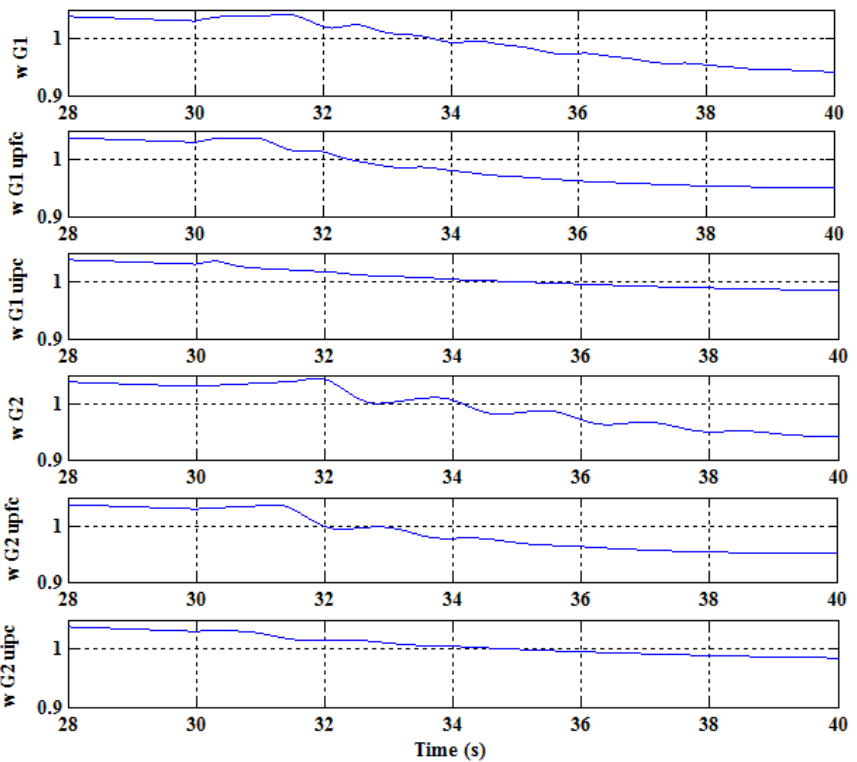
Figure 7. Speed of generators 1 and 2 (left side G1 and G2) in three states without a compensator, using UIPC and UPFC.